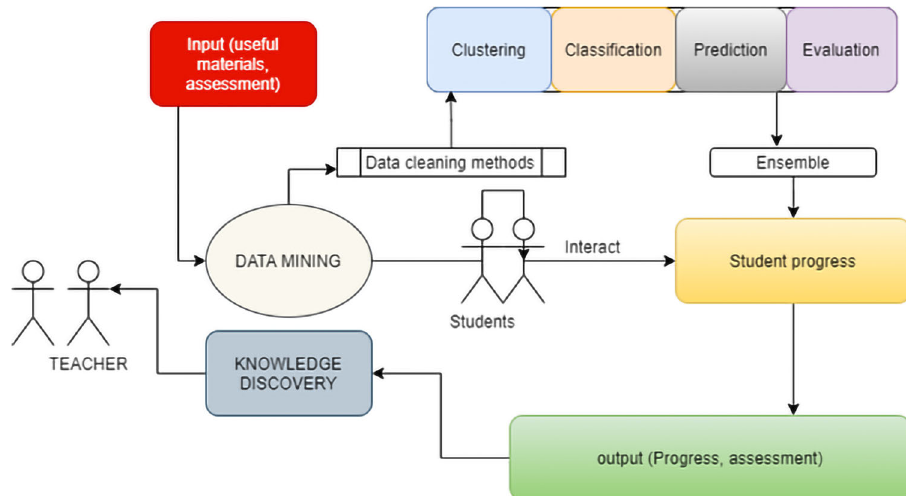
Fig. 2 Main architecture of the proposed system.